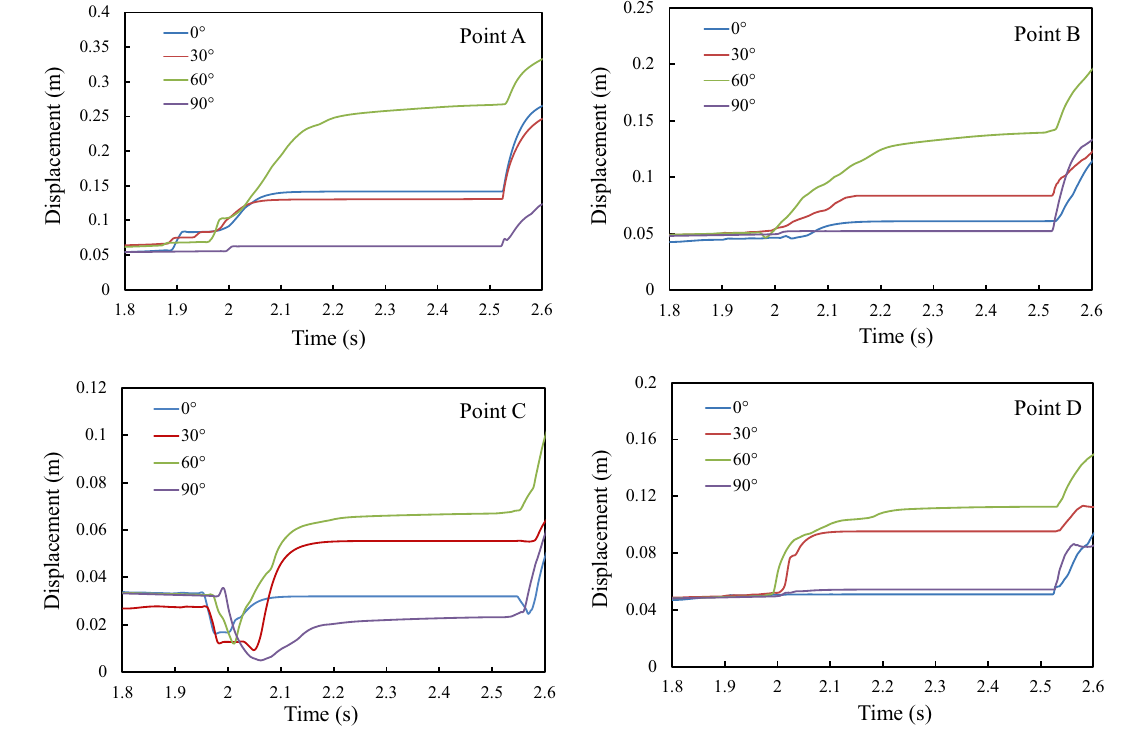
Fig. 18 Displacement–time evolution curves for four monitoring points at different dip angles of structural plane. Note: Point A is located in roof, Point B is located in right side, Point C is located in floor, and Point D is located in left